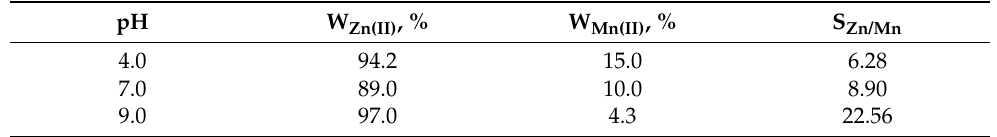
Table 6. Influence of pH on the degree of Zn(II) and Mn(II) cations separation with the use of collector 33 after 10 min process from the real solution without foaming agent 29 at pH from 4.0 to